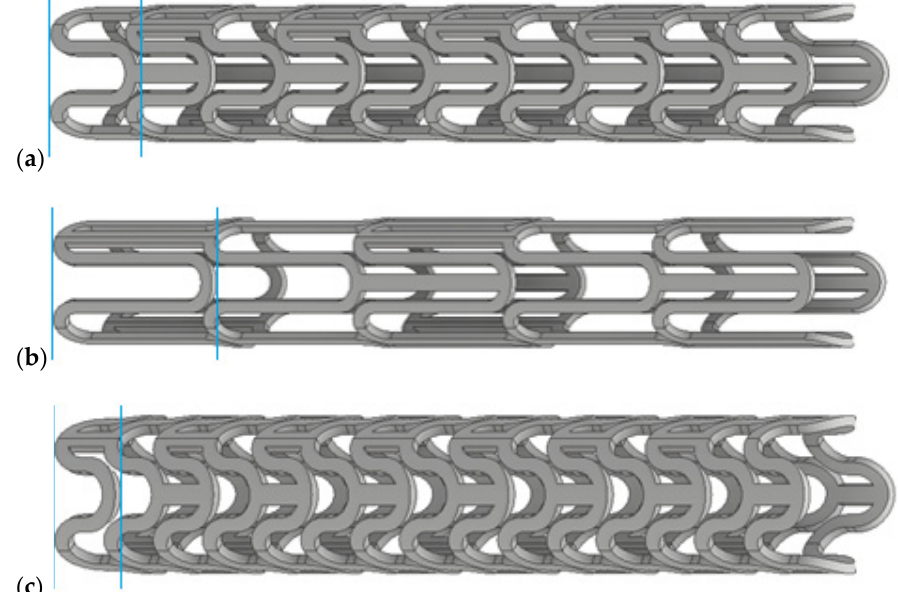
Figure 3. Geometric models of stents, for which crown length is marked between the two sections and is: ( a ) optimal, ( b ) too wide, and ( c ) too narrow.